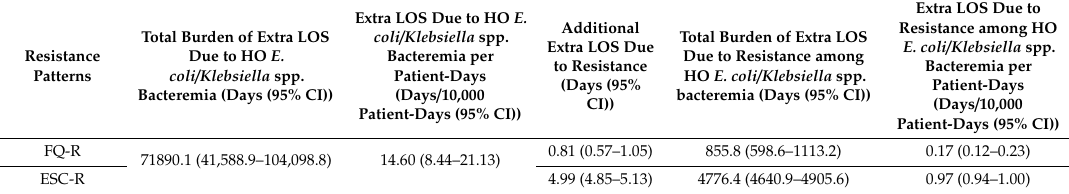
Table 3. Burden of extra length of stay due to hospital-onset Escherichia coli / Klebsiella spp. bacteremia and fluoroquinolone / extended-spectrum cephalosporin resistance, per 10,000 patient-days within the Veterans Health Administration (VHA) System